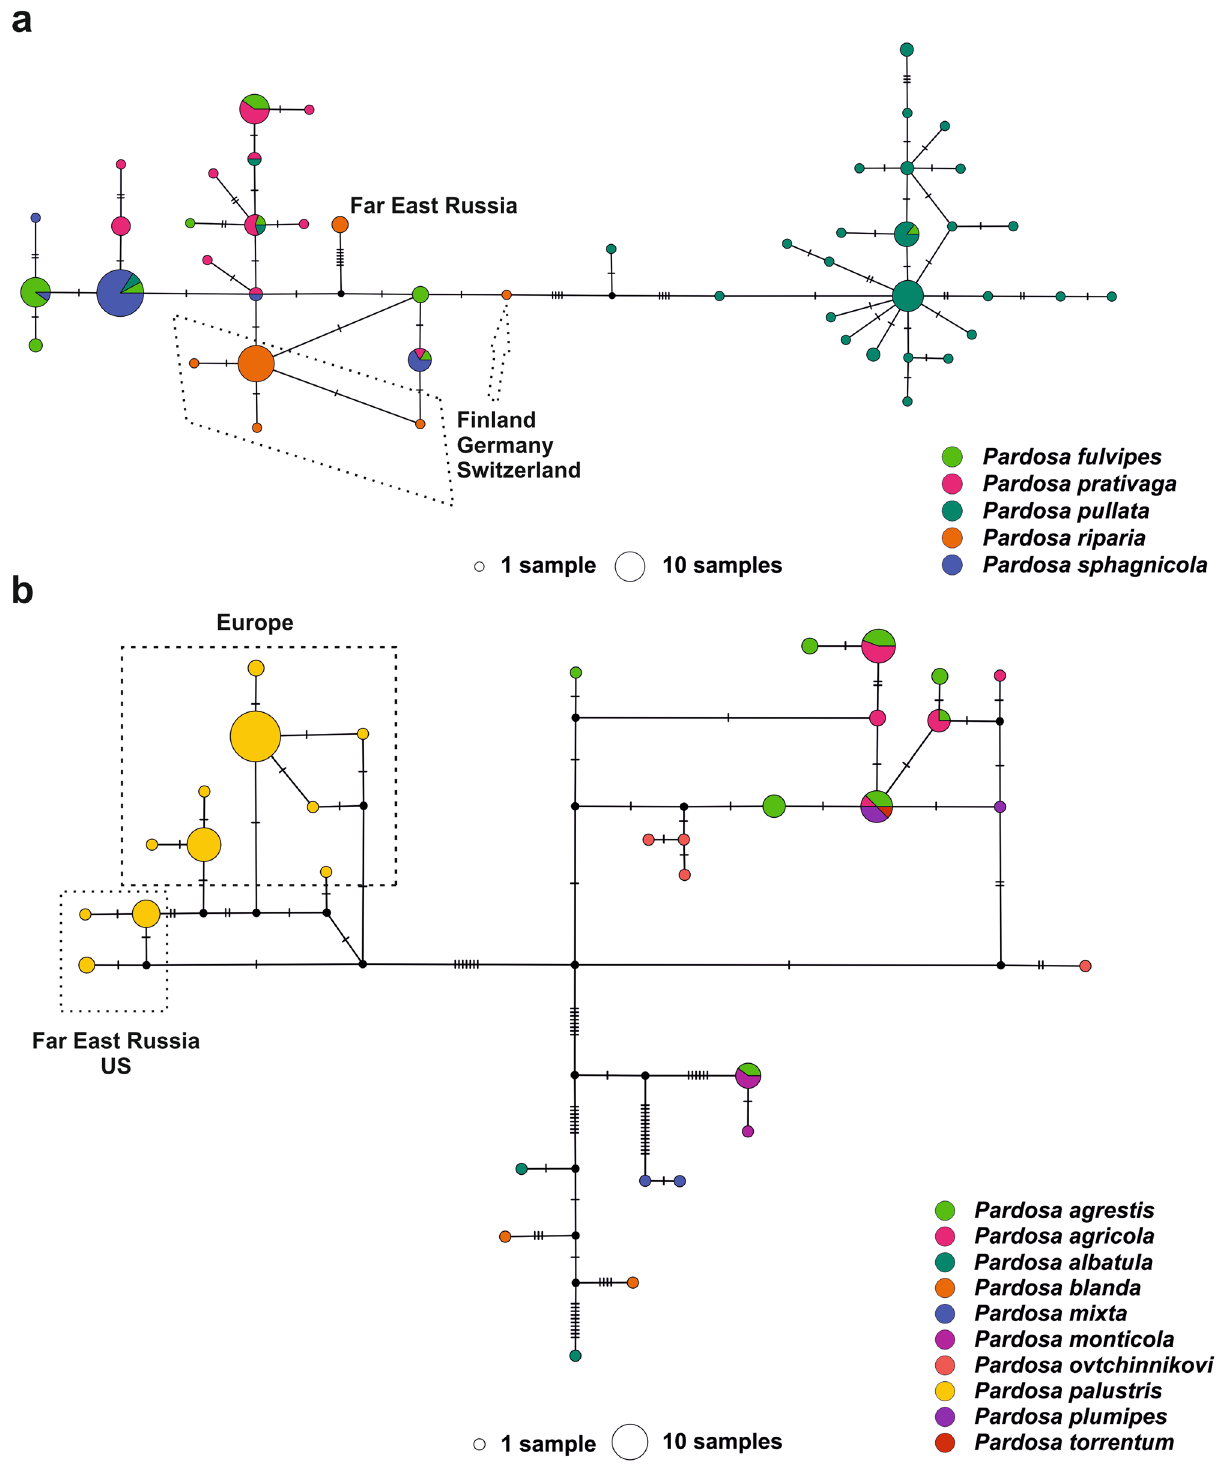
Figure 2. COI haplotype networks. ( a ) pullata species group, ( b ) monticola species group. Each circle represents a haplotype and circle size is proportional to strain frequency. Different colors represent different species. Lines between haplotypes and short solid lines are single mutational steps. Dotted lines outline haplotypes by populations. Black dots are predicted or missing